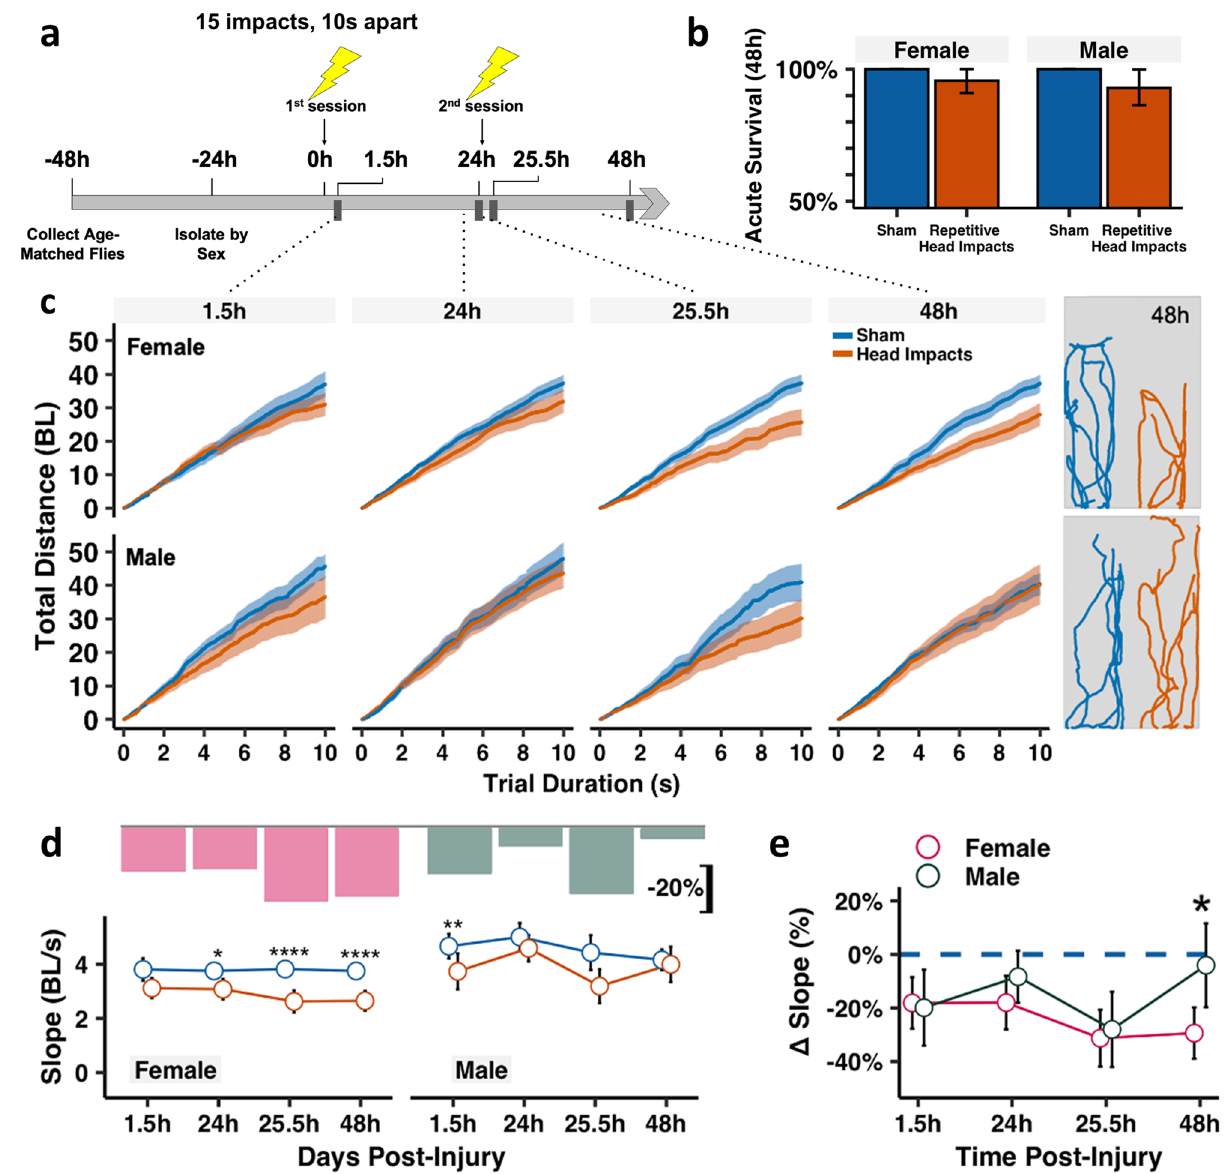
Figure 2. Acute recovery of climbing deficits following minimally lethal repetitive head impacts is sexually dimorphic. (a) Injury timeline schematic showing that flies are subjected to two sessions of repetitive head impacts (24 h apart). Each session consists of 15 iterative impacts spaced 10 s apart. Behavior and mortality are longitudinally monitored throughout life. ( b) Bar graph showing acute survival following repetitive impacts with 95% confidence intervals. n = 56–69 flies per injured group/sex and n = 42–50 flies per sham group/sex. (c) Total cumulative distance traversed during the negative geotaxis assay. Plotted values are median with 95% confidence intervals as shaded regions, (Right) Representative movement tracings from 5 representative flies/group of sham (blue) and injured (orange) flies during the 10 s trial duration at 48 h. Distance units are in body lengths (BL). ( d,e) Plotted climbing slope showing that injured females exhibit a progressive decrease that worsens after the second impact session, while injured male flies show active acute recovery 24 h after each session of impacts. Bar plots in ( d ) correspond to the median relative decrease in climbing performance between injured and sham groups (∆ slope = (Injured Slope-Median Sham Slope)/Median Sham Slope). Plotted values are median with 95% confidence interval error bars in ( d,e) . Mann–Whitney U test between ( d) injured and non-injured groups, with Holm correction and ( e ) injured female and male performance relative to non-injured, with Bonferroni correction. *p < 0.05, **p < 0.01, ***p < 0.001, ****p < 0.0001, n = 25–35 flies per sex/time/injury